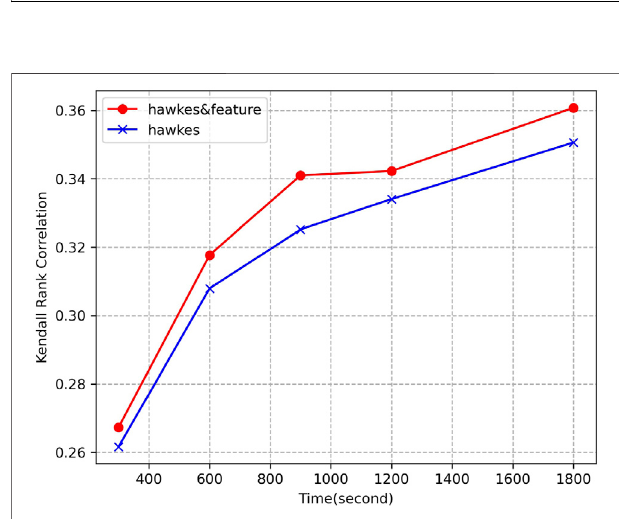
FIGURE 5 | Comparison of Kendall rank correlation for two models on dataset